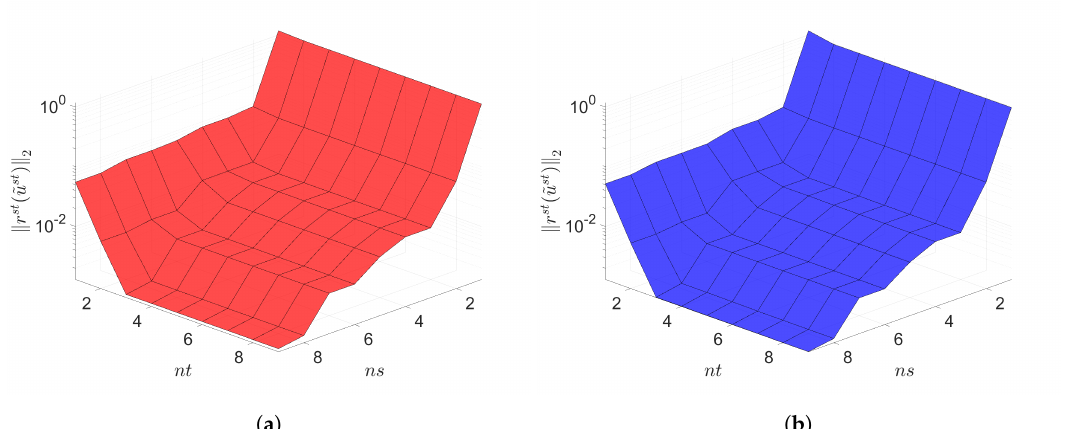
Figure 5. 2D linear diffusion equation. Space-time residuals vs. reduced dimensions. Note that the scales of the z -axis, i.e., the residual norm, are the same both for Galerkin and LSPG. Although the LSPG achieves slightly lower minimum residual norm values than the Galerkin, both Galerkin and LSPG show comparable results. ( a ): Space-time residuals vs. reduced dimensions for Galerkin projection, ( b ): Space-time residuals vs. reduced dimensions for LSPG projection.